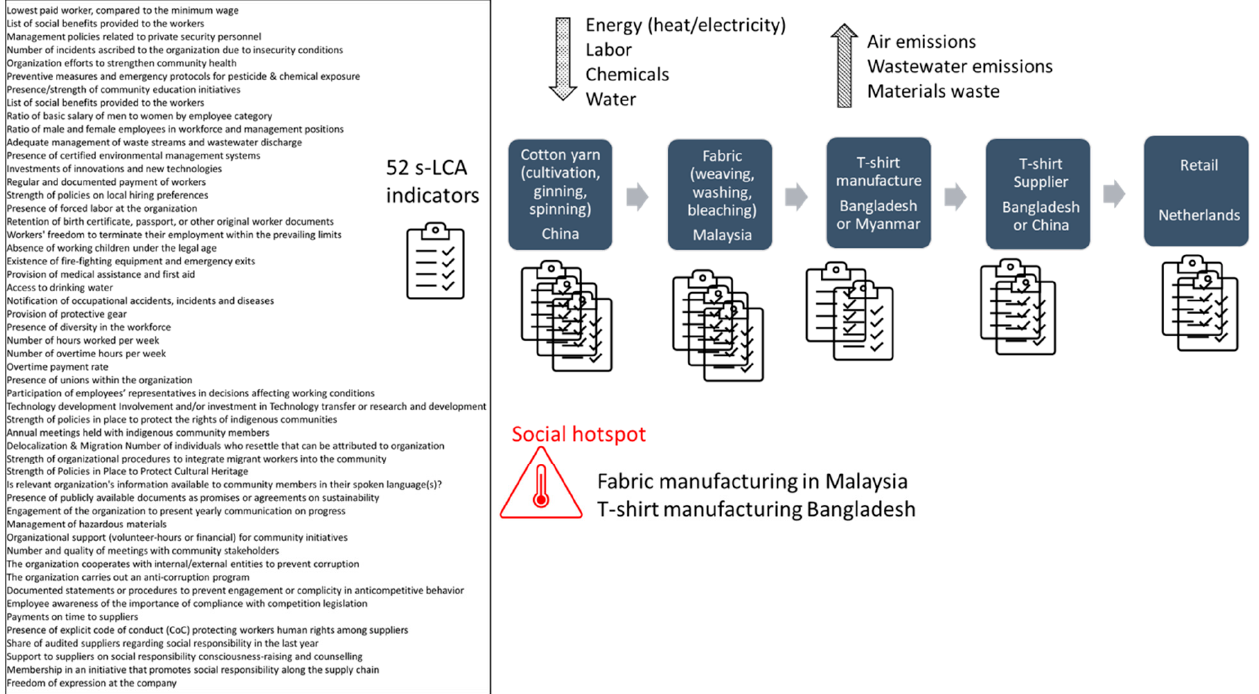
Figure 4. Possible boundaries for LCA studies related to apparel. Cradle-to-gate #1, #2, #3 and (w/transport #4 1–8); cradle- to-use #1, #2, #3, #5 and (w/transport #4 1–11).